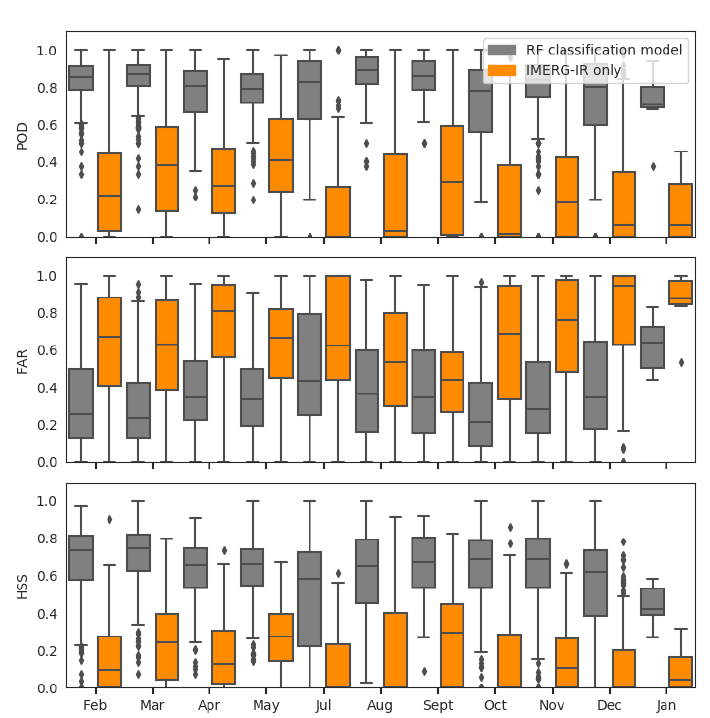
Figure 6. Standard verification scores for the RF classification model (rain area). The scores were calculated on a scene-by-scene basis. Boxes show 25th, 50th, and 75th percentiles. Whiskers extend to the most extreme data points between 75th and 25th percentile. Outliers are shown as